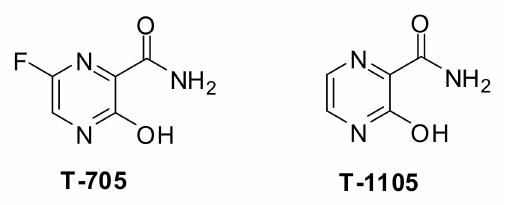
Figure 1. RNA viral polymerase inhibitors T-705 and